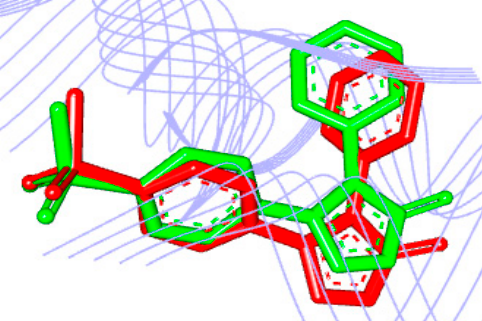
Figure 3. Overlapping of the crystallographic ligand ( green ) and the conformation obtained by re-docking ( red ). Table 2. Comparison between experimental and theoretical binding a ffi nities.